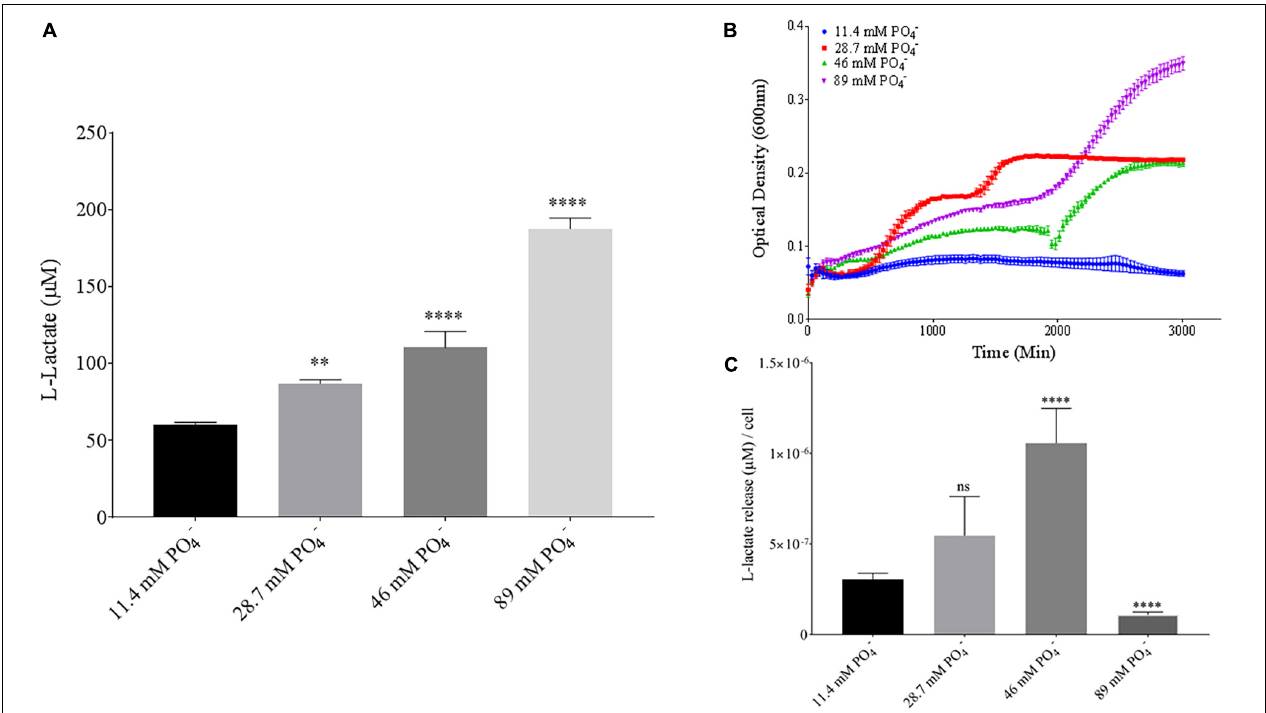
FIGURE 11 | Bacillus pumilus B12 changes L-lactate release in PO 4 − when normalized for growth. (A) Initial measurements of B. pumilus B12 L-lactate release from PLA taken after 48 h. PO 4 − concentration increases are based off standard MSM with glucose (MSM + G). These assays were performed with three biological and three technical replicates. (B) Optical density-based growth curves of B. pumilus B12 taken over 48 h in different PO 4 − concentration. Each growth curve represents 8 biological replicates. (C) Relative release of L-lactate/cell based on growth after 48 h. ∗∗∗∗ indicates ANOVA p -value ≤ 0.0001, ∗∗ indicates ANOVA p -value ≤ 0.01, and ns is p -value > 0.05, all compared to MSM + G